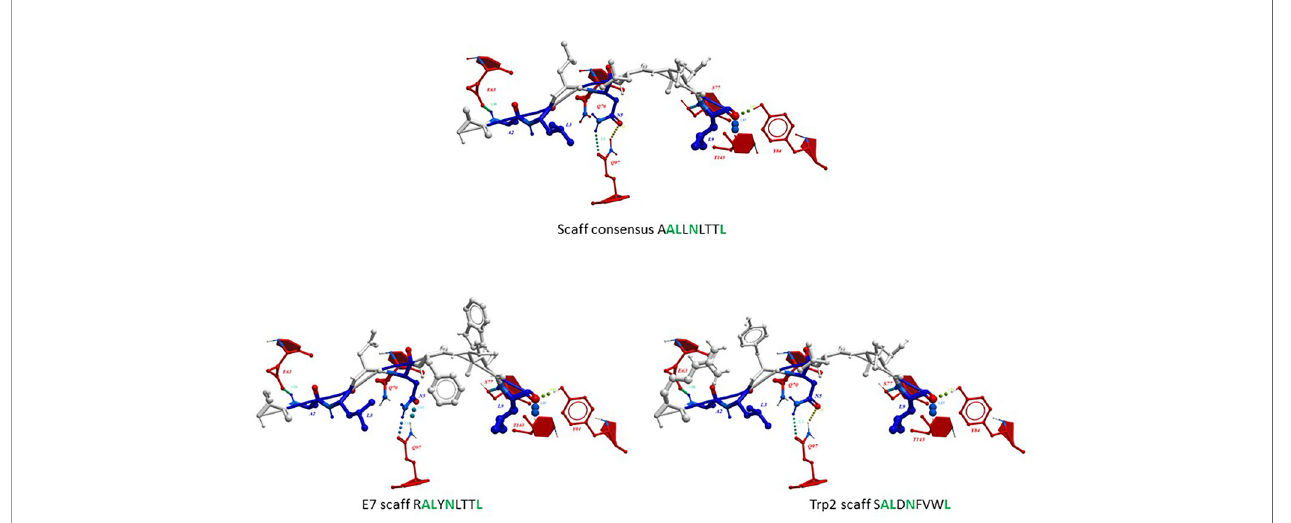
FIGURE 4 | Predicted conformation of scaffolds. The conformation of the HPV-E7 and Trp2 scaffolds bound to the H2-Db molecule are compared to the consensus scaffold. The hydrogen bonds with H-2Db residues are indicated for the anchor